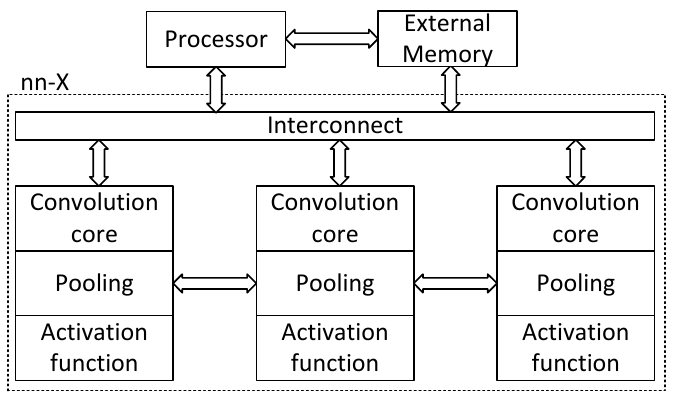
Figure 8. Architecture of neural network-Next